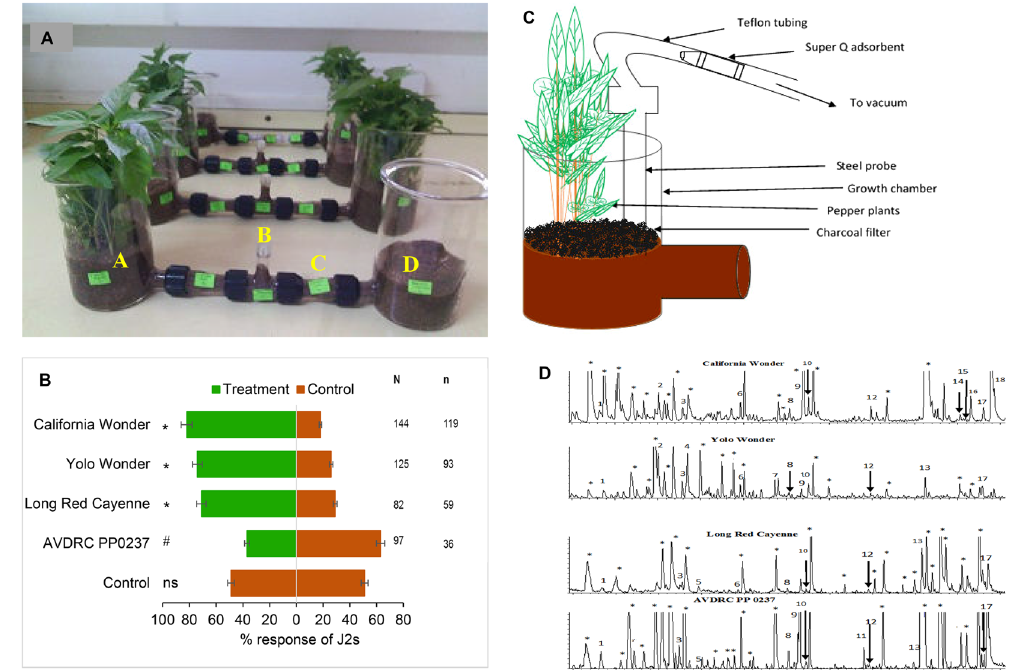
Figure 1. Response of Meloidogyne incognita infective juveniles (J2s) to root volatiles of pepper and chemical analysis of the root volatiles. ( A ) Dual choice olfactometer assays to test J2 responses to Capsicum annum root volatiles and synthetic blends: ( A ) Stimulus chamber, ( B ) Release arm ( C ) Connecting arm, ( D ) Control chamber. ( B ) Response of M . incognita to root volatiles of three pepper cultivars and one accession compared to a control (moist sand). N corresponds to the total mean of responding J2 while n is the number of J2 corresponding to a given treatment. The level of significance is indicated by: * P < 0.0001; # P < 0.05; ns = not significant at P = 0.05. ( C ) A schematic representation of the volatile collection set-up in the laboratory. ( D ) Gas chromatography-mass spectrometry chromatograms of root volatiles of Capsicum annum . Numbers correspond to the following compounds (1) α -Pinene (2) Decane (3) D-Limonene (4) (Z)- β -Ocimene (5) p -Cymene (6) Undecane (7) Camphor (8) 2-Methoxy-3-(1-methylpropyl)-pyrazine (9) Dodecane (10) Methyl salicylate (11) Thymol (12) Tridecane (13) Tetradecane (14) γ - Himachalene (15) Allo-aromadendrene (16) α –Muurolene (17) 4,5-Di-epi-aristolochene (18) γ – Gurjunene (see also Table 1). Asterisk ( * ) indicates matrix interferences present in the control and